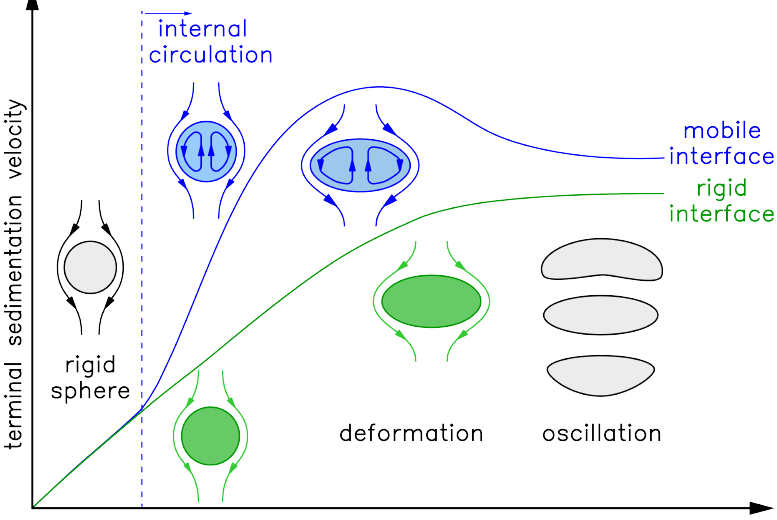
Figure 1. Fluid dynamics behavior of sedimenting single drops, drop shape and terminal drop velocity as a function of the drop diameter in case of a rigid interface (green line) and a mobile interface (blue line), the onset of internal circulation is indicated by the dotted blue line. (Based on